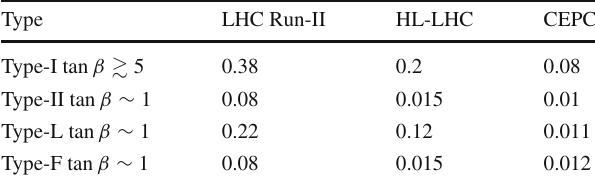
Table 3 Apart for the wrong-sign region, the maximally allowed | cos (β − α) | range at 95% C.L. given LHC Run-II, HL-LHC (including both ATLAS and CMS), and CEPC Higgs precision